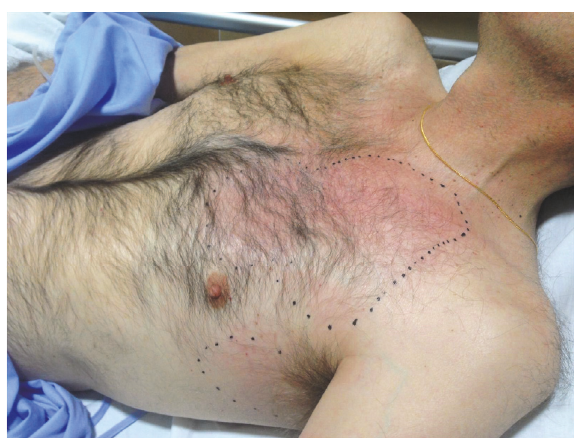
Figure 1: Erythematous plaque in a kidney transplanted patient in the left chest area, slightly painful.